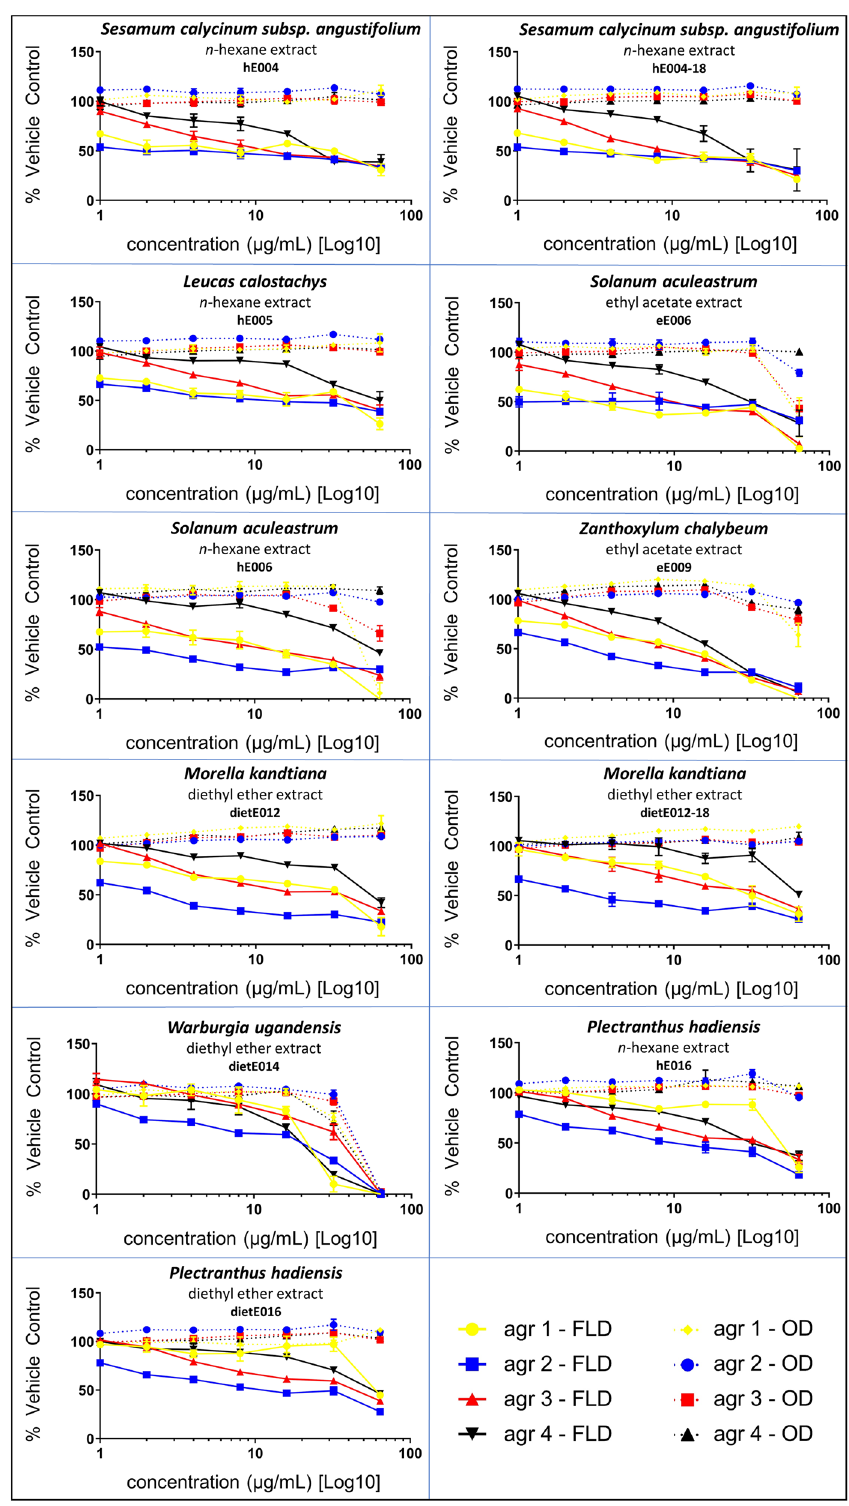
Figure 3. Results of the quorum-sensing inhibition in vitro dose-response studies: Data shown as serial dilution and percent agr activity or growth of the vehicle control (DMSO) at 22 h; FLD: fluorescence detector (measuring quorum sensing activity), represented by solid lines; OD: optical density at 600 nm (measuring bacterial growth), represented by dashed